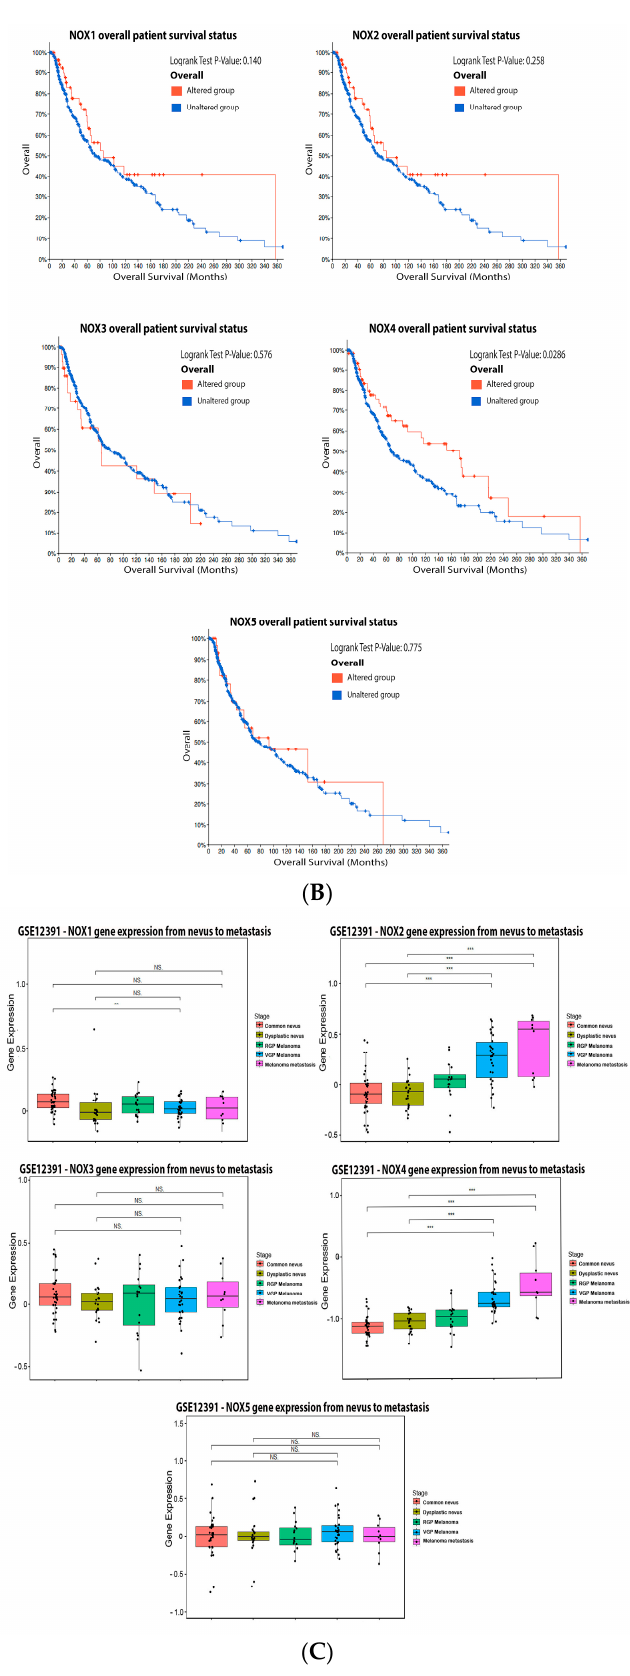
Figure 2. NADPH oxidases on melanoma. ( A ) Percentage of patients with altered genes and types